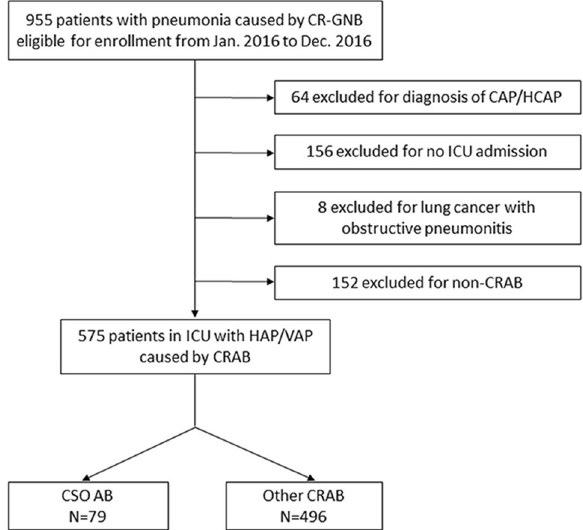
Figure 1. Flow diagram for patient inclusion and